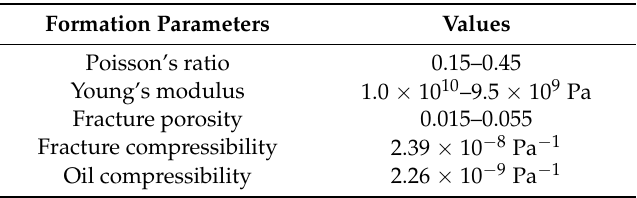
Table 4. Basic data of KT-I formation in North Truva field.